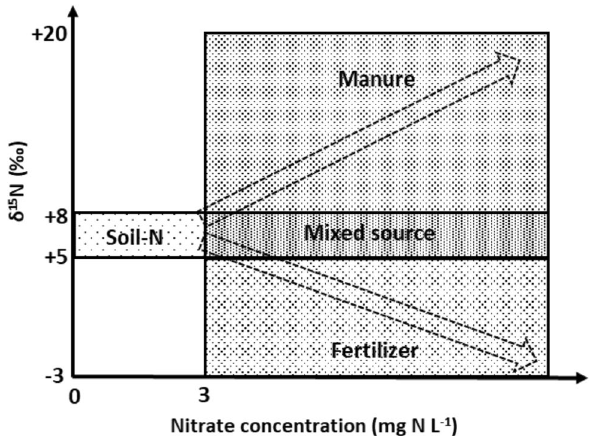
Fig. 4 Typical relationships between concentration and δ 15 N of groundwater nitrate-N for different sources of nitrate-N. Above 3 mg nitrate-N L −1 , a positive correlation between concentration of nitrate-N and δ 15 N indicates the 15 N-enriched source such as organic manures, whereas 15 N-depleted sources such as mineral fertilizers result in a negative correlation. Modified from Choi et al.